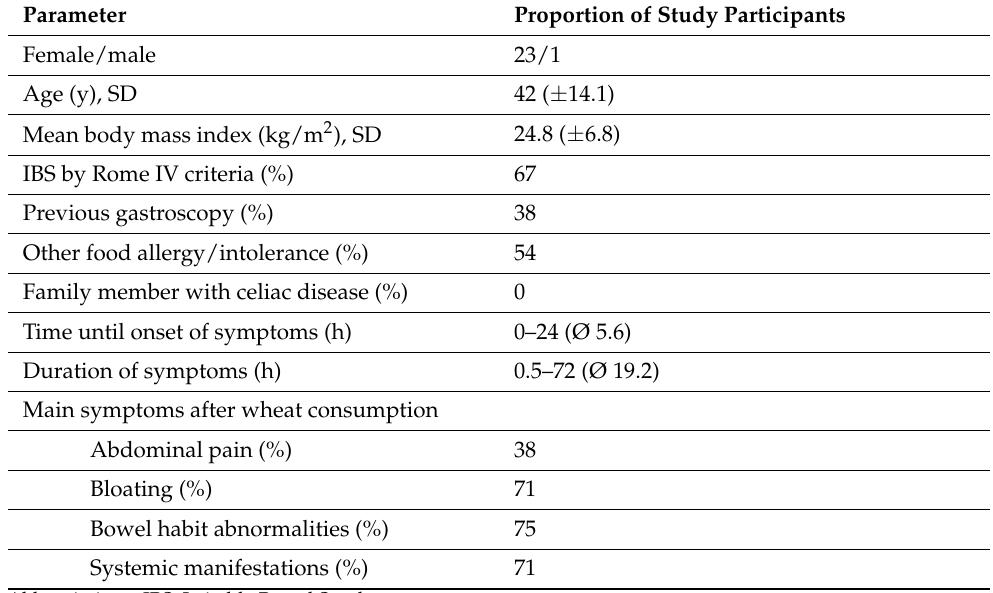
Table 2. Baseline characteristics ( n =